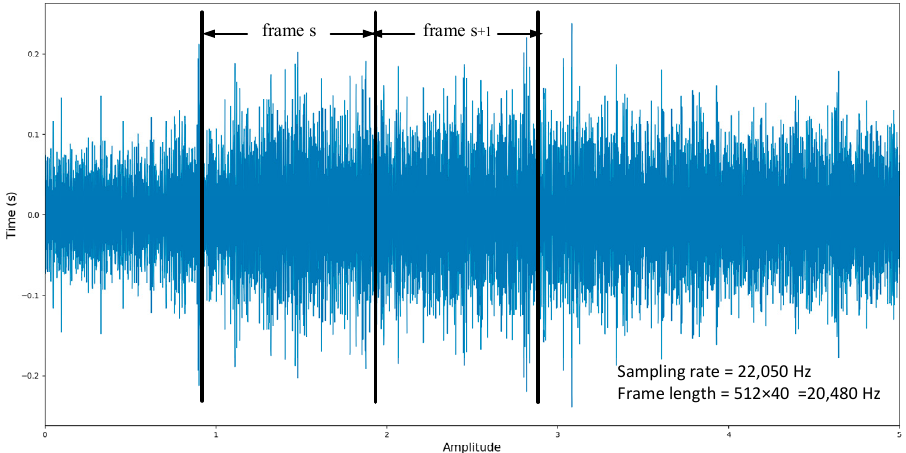
Figure 2. Framing the signal of the type of passengers into several frames s and s + 1 with no overlapping.